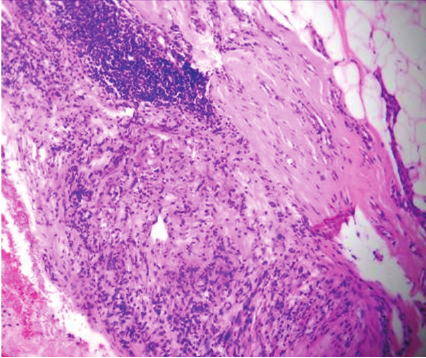
Figure 6: (Case 2): biopsy from skin lesion showing epithelioid granuloma in the subcutaneous nerve twig (H&E × 100).